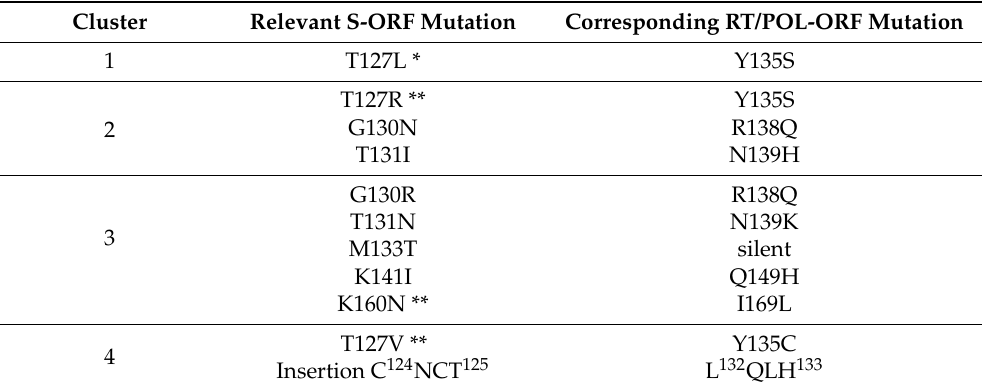
* HBsAg subtype change to ayw4 in comparison to the sgtD3 reference isolate of subtype ayw3 . ** Inactivation of HBsAg subtype determinant w